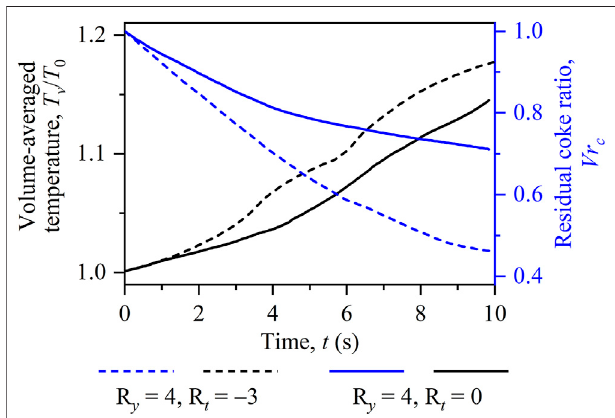
FIGURE 11 | Temporal evolutions of the volume-averaged temperature T v / T 0 and the residual coke ratio Vr c for the two cases with R y (cid:2) 4, R t (cid:2) 0 and R y (cid:2) 4, R t (cid:2) −